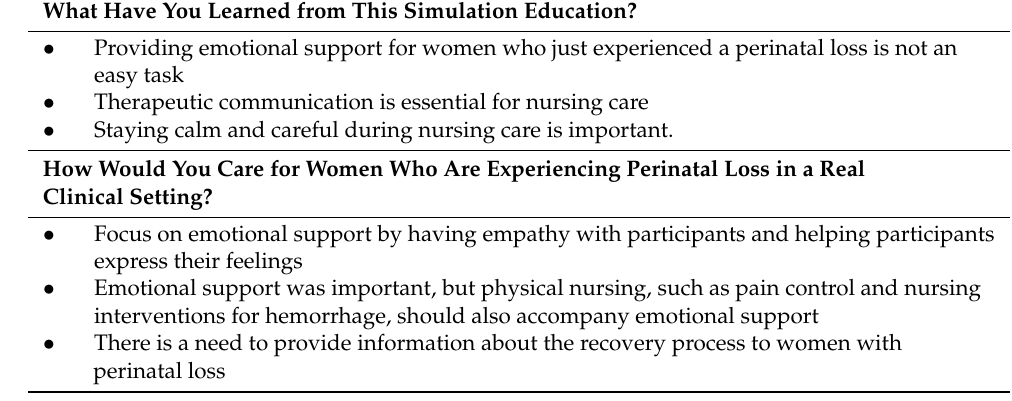
Table 4. Questions and results of open-ended